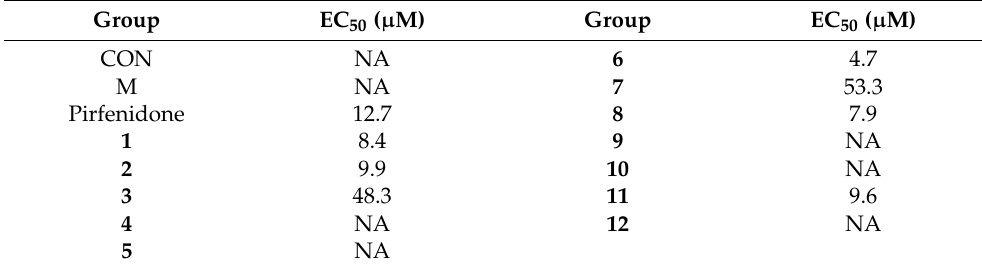
Table 3. Anti-pulmonary fibrosis activities of compounds 1 – 12 against BEAS-2B cell damage induced by TGF- J 1. Group EC 50 ( µ M) Group EC 50 ( µ M) CON NA 6 4.7 M NA